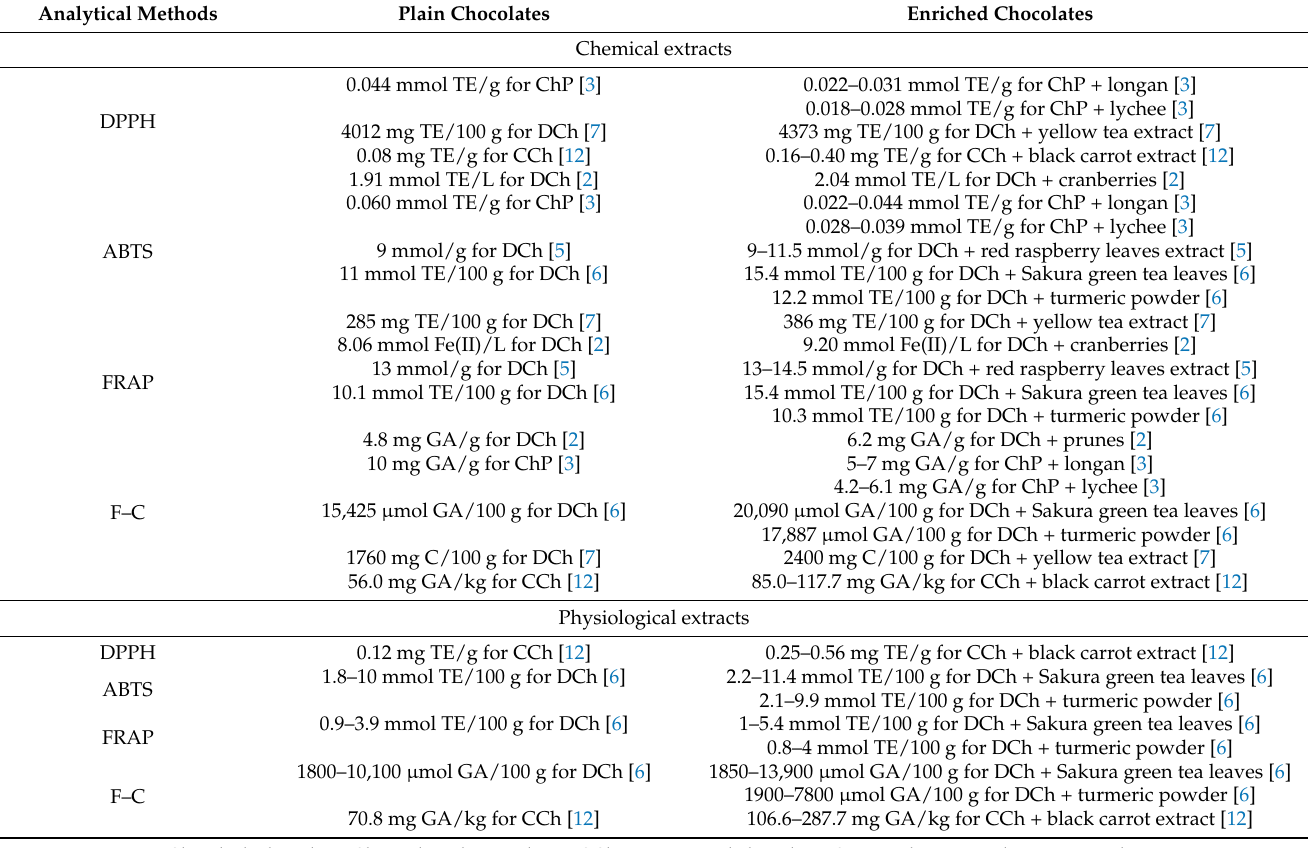
Table 4. Antioxidant capacity and total phenolic content in plain and enriched chocolates, as determined by other authors. Analytical